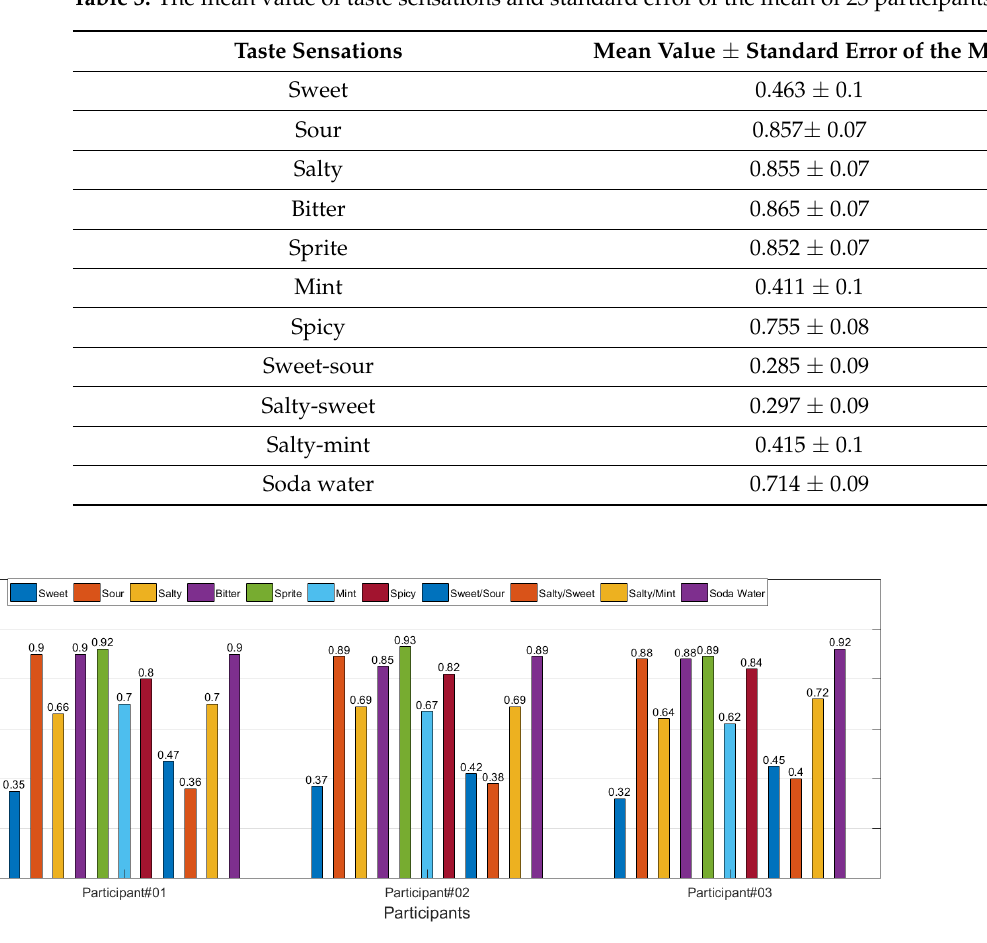
252 Figure 7. The average percentage of taste sensations of 23 participants with repeated experiments. Error bar depicts 90 – 98% CI. All data are expressed as mean ± SD ⁎⁎ p ≤ 0.05. 4. Discussion and Future Work Our ‘e - taste device’ revealed strong and modified taste sensations for sweet, sour, salty, mint, spicy, bitter, and various flavors like sprite, soda water, sweet-sour, salty-